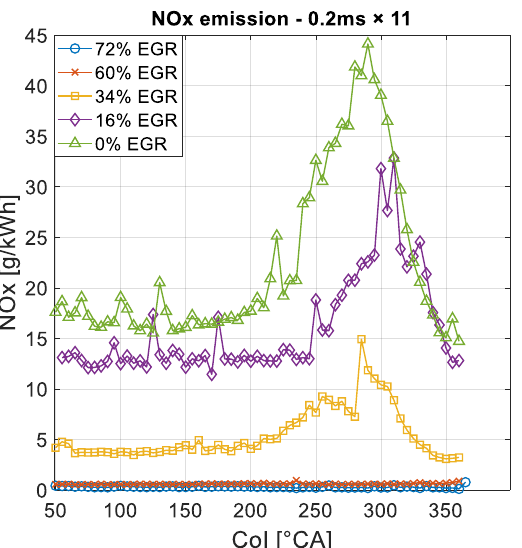
Figure 18. The temperature maxima of the 0.2 ms × 11 structure with different EGR rates in the function of CoI.